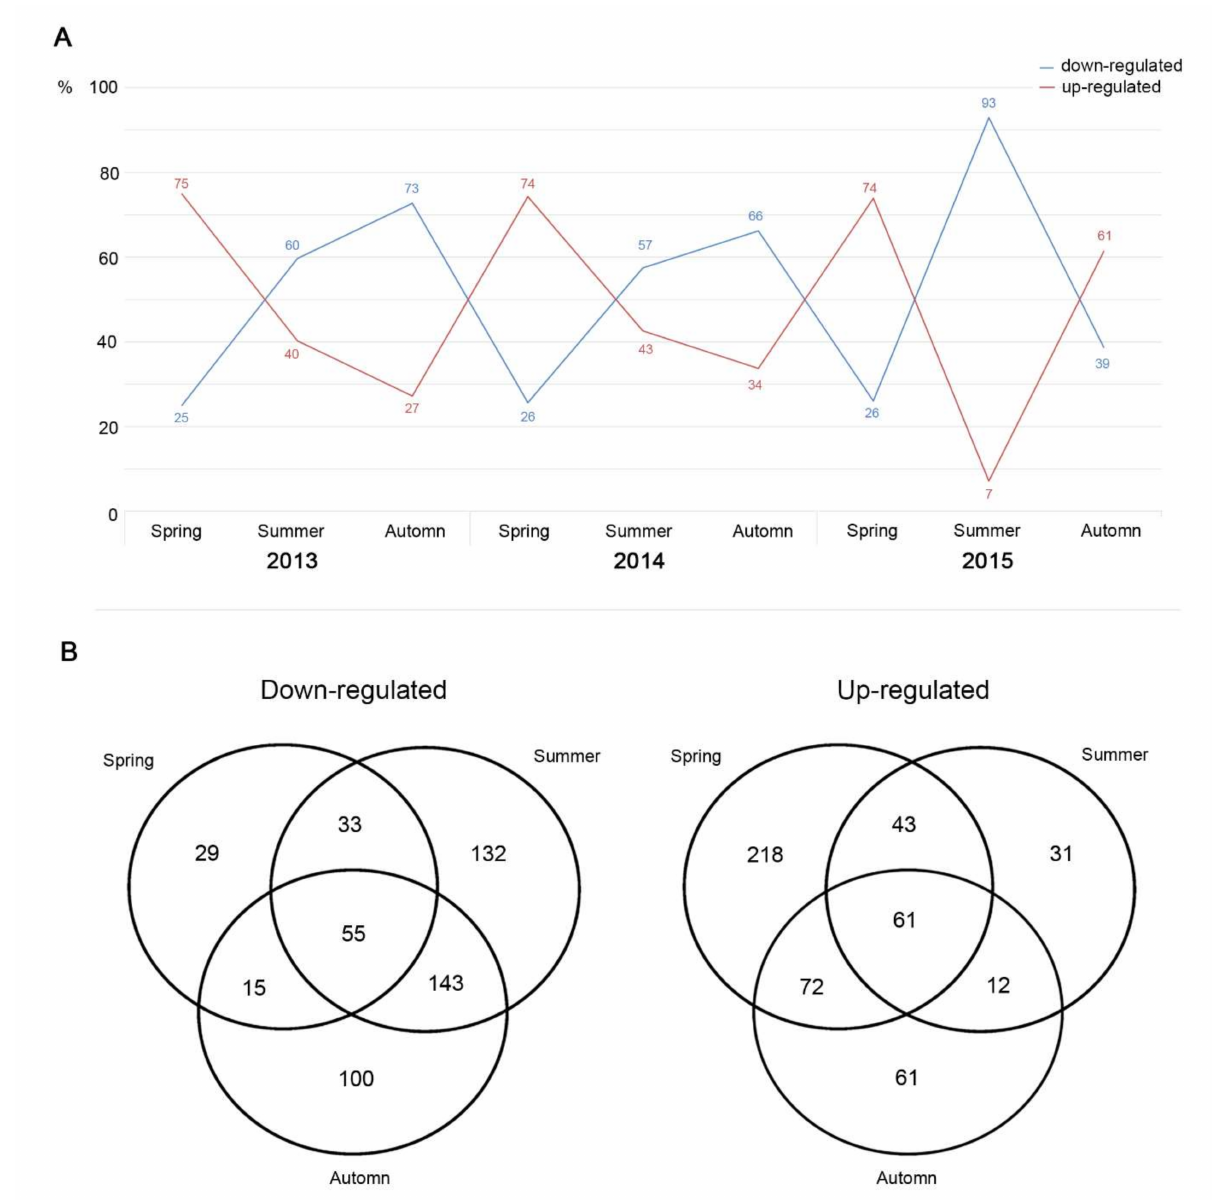
Figure 3. ( A ) Percentage of upregulated (in red) and downregulated (in blue) features according to years and seasons. ( B ) Venn diagram giving the repartition of downregulated ( left ) and upregulated ( right ) metabolites under drought according to seasons (with merged